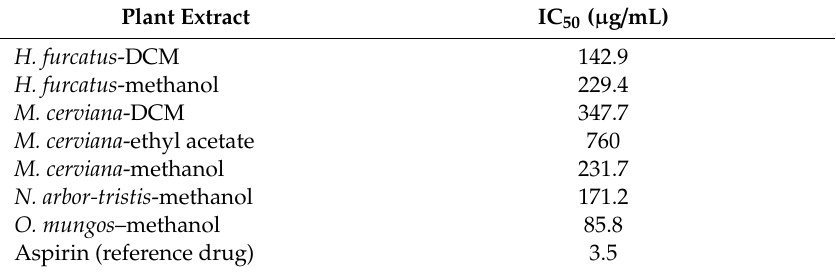
Table 2. IC 50 values for the NO scavenging activity. Data are given as means, n = 3. Plant